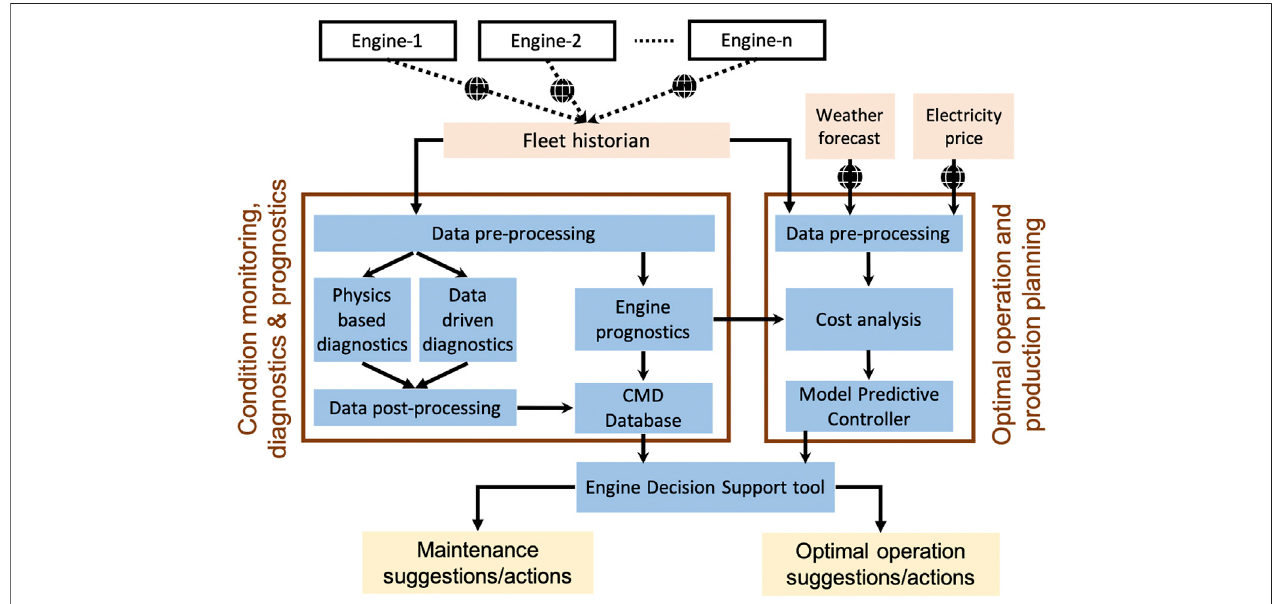
FIGURE 4 | Framework for micro gas turbine fl eet monitoring, diagnostics, and production planning.